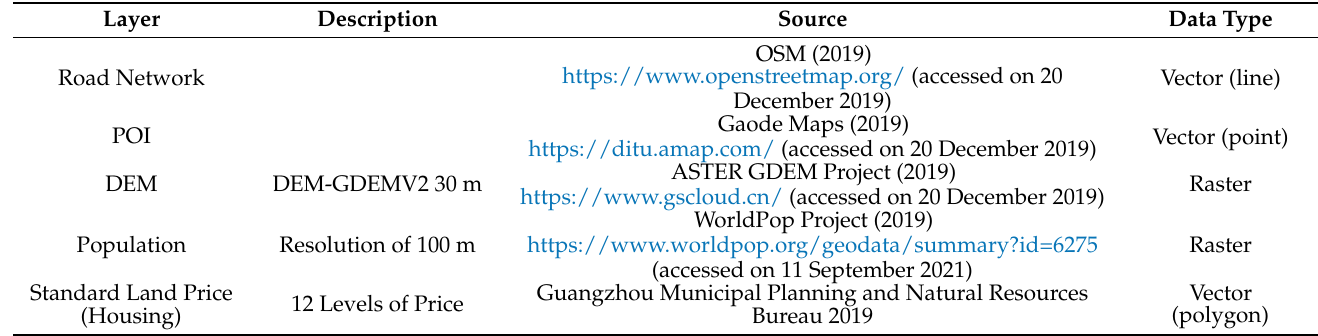
Table 1. List of data used.